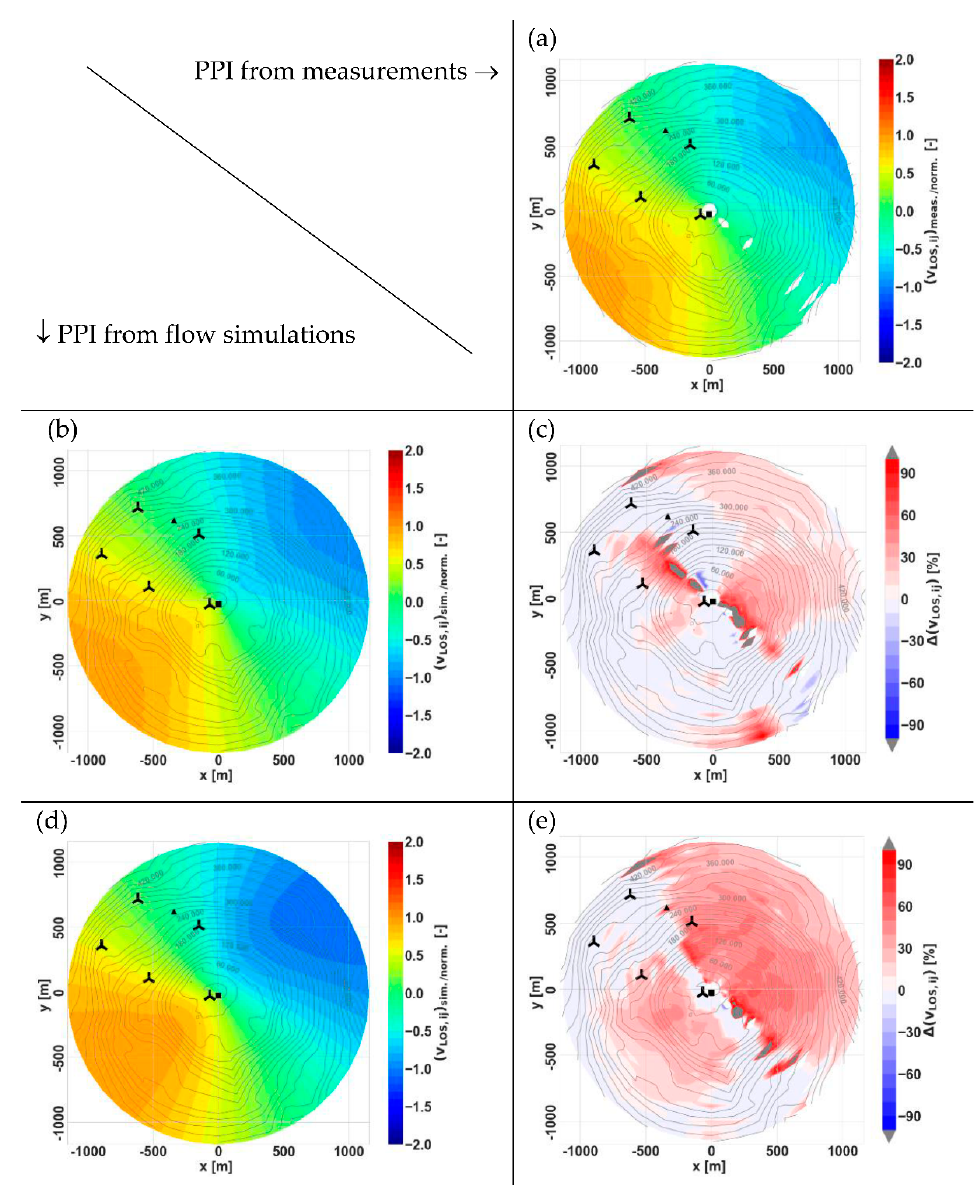
Figure 5. Measured and simulated PPI patterns, as well as their deviations, for a selected individ- ual flow situation (12 February 2020 01:30 UTC)—( a ) (𝑣 (cid:3013)(cid:3016)(cid:3020),(cid:3036)(cid:3037) ) (cid:3040)(cid:3032)(cid:3028)(cid:3046)./(cid:3041)(cid:3042)(cid:3045)(cid:3040). from scanning lidar (cid:16) (cid:17) v LOS , ij flow situation (12 February 2020 01:30 UTC)—( a ) from scanning lidar measure- measurements, ( b , d ) (𝑣 (cid:3013)(cid:3016)(cid:3020),(cid:3036)(cid:3037) ) (cid:3046)(cid:3036)(cid:3040)./(cid:3041)(cid:3042)(cid:3045)(cid:3040). from numerical simulations with FIWind and FITNAH, meas ./ norm . (cid:16) (cid:17) respectively, ( c , e ) the corresponding deviations ( ∆𝑣 (cid:3013)(cid:3016)(cid:3020),(cid:3036)(cid:3037) ) . v LOS , ij ments, ( b , d ) from numerical simulations with FIWind and FITNAH, respectively, sim ./ norm . ( c , e ) the corresponding deviations ( ∆ v LOS , ij